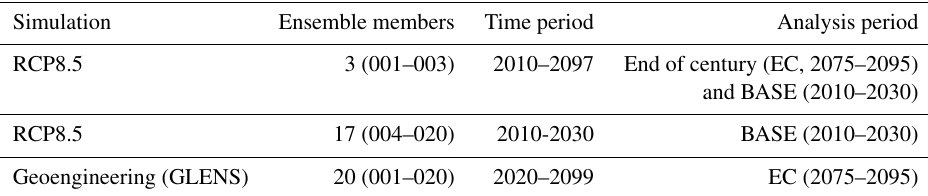
Table 1. Summary of simulations carried out as part of the GLENS project: simulation name, ensemble members, simulation time period, and analysis